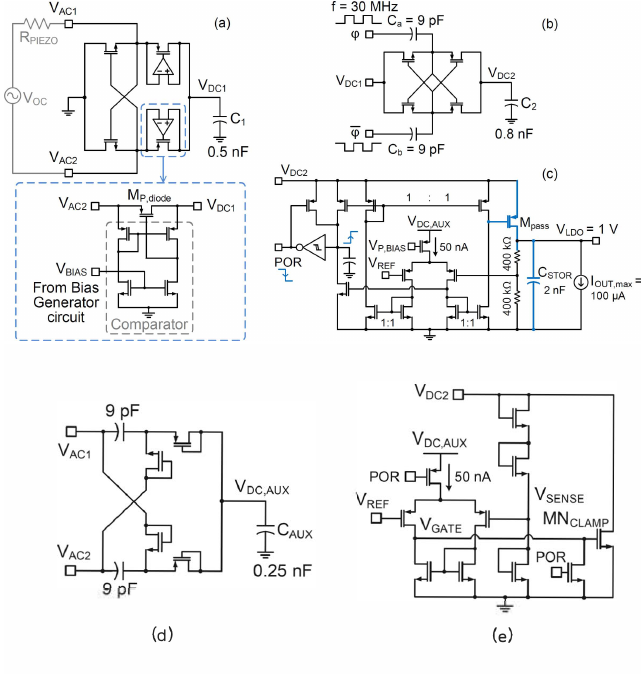
Figure 15. Power recovery circuits in the main power path [44]: ( a ) active full-wave rectifier and the comparator used in the active PMOS diode; ( b ) high-frequency voltage doubler; ( c ) LDO circuit and generation of the POR signal; ( d ) Push-pull voltage doubler circuit used in the auxiliary power path; ( e ) Over-voltage protection circuit for V DC 2 rail. Reproduced with permission from J. Chartad, IEEE Journal of Solid-State Circuits; published by IEEE, 2015.